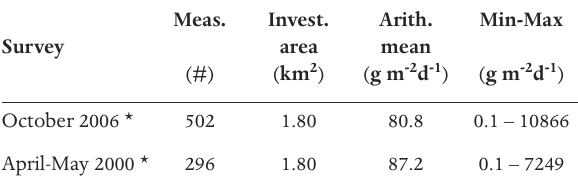
flux measurements on the Vesuvio Table 1. Statistics of the CO 2 cone. *: corrected for the topographic effect (see